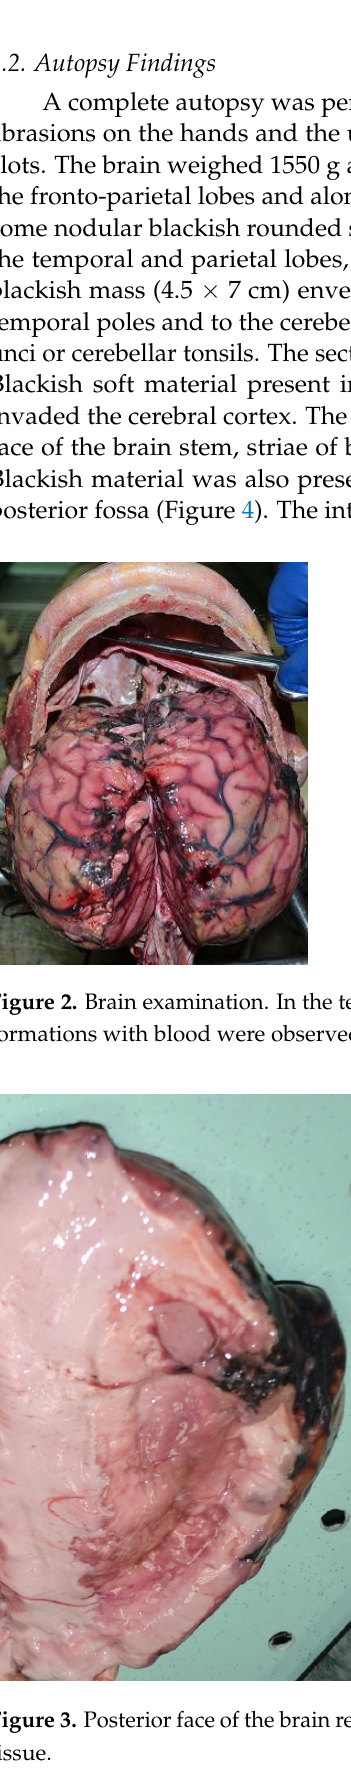
Figure 4. Skull base-posterior fossa and venous sinus examination showed a blackish material. 2.3. Histological Analysis During the autopsy, brain samples were collected that were fixed in 10% buffered formalin. After washing, the water was removed, and they were embedded in paraffin. The obtained blocks were cut (4 µm thickness), using a microtome (Dako, Glostrup, Den- mark), sectioned, and stored at room temperature. Sections were stained with Hematox- ylin and Eosin (H&E) and Von Gieson’s method. The immunohistochemical analysis of the samples was performed through antimelanoma-antibody (HMB45+), Melan A-anti- body, CD3-antibody, CD20+-antibody, PenCK-antibody, Ki67+, as suggested by Tosaka